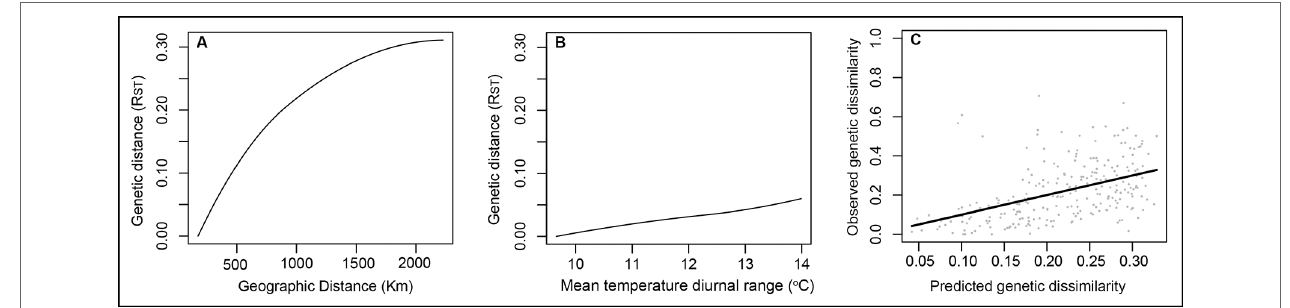
FiGUrE 2 | GDM-fitted I-splines for the geographic distance (A) and mean temperature diurnal range (B) associated with genetic differentiation in Qualea grandiflora . The maximum height of each curve indicates the total amount of genetic differentiation associated with that variable holding all other variables constant and the curve shape shows how the rate of genetic differentiation varies along the gradient. ( Panel c) illustrates observed versus predicted genetic dissimilarity.